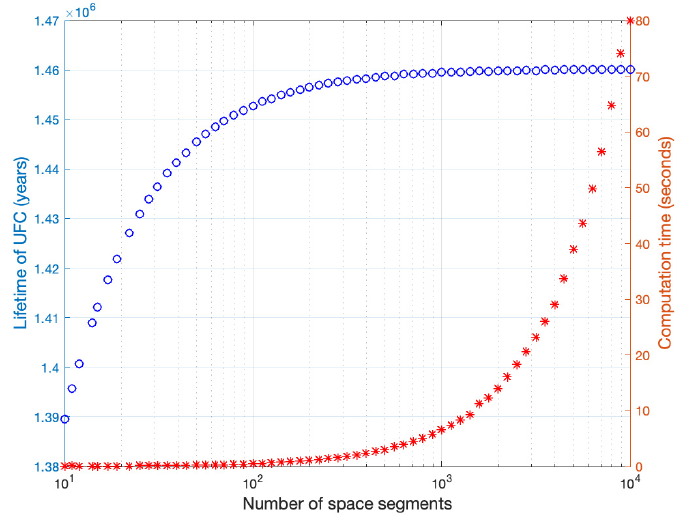
Figure A1. UFC lifetime and computation time for different number of spatial segments.